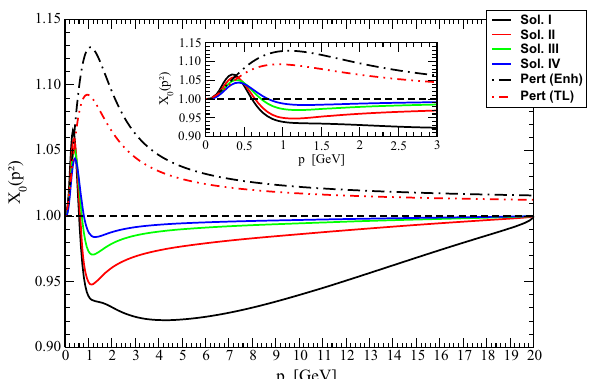
Fig. 20 X 0 ( p 2 ) from inverting the Dyson–Schwinger equations together with its estimation using one-loop dressed perturbation the- ory by solving exactly Eq.